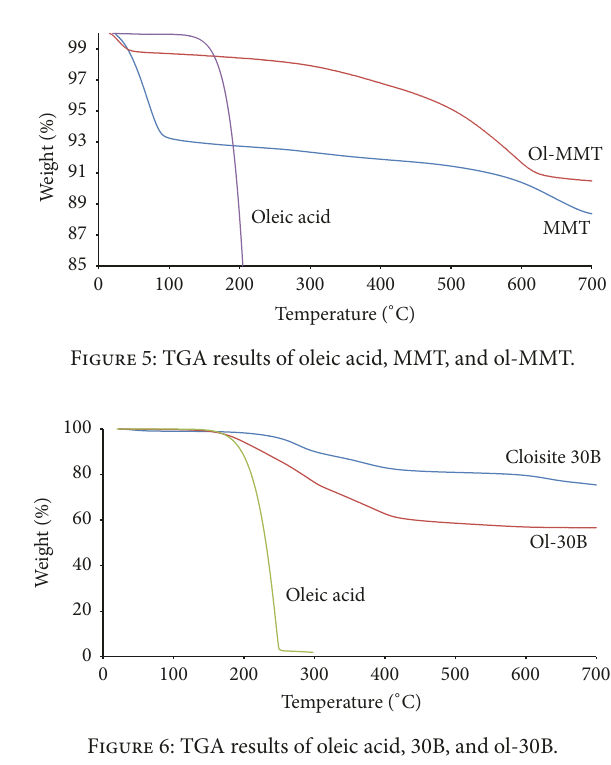
Figure 6: TGA results of oleic acid, 30B, and